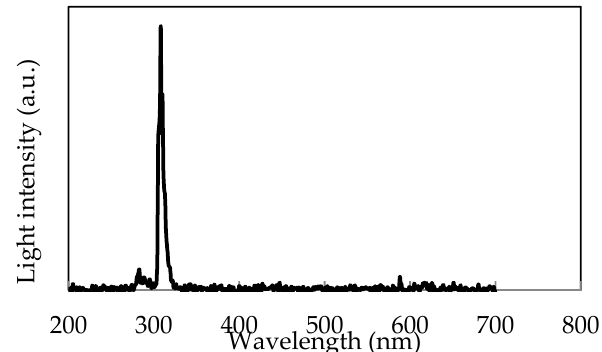
Figure 7. Light intensity spectrum of the hydrogen flame with a peak at around 310 nm.